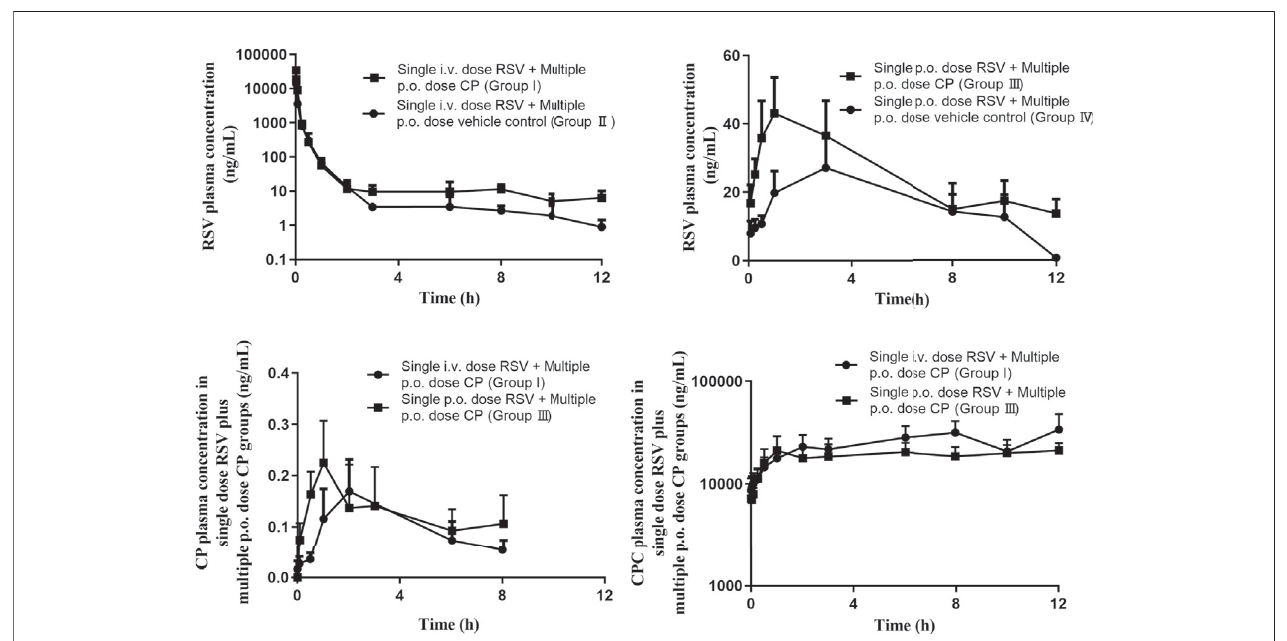
FIGURE5| Meanplasmaconcentration-timepro fi lesofRSV (AandB) ,CP (C) ,andCPC (D) inrats.Dataarepresentedasthemean ± S.D.(n (cid:2) 4).p.o.dose:p.o. administration as oral gavage.